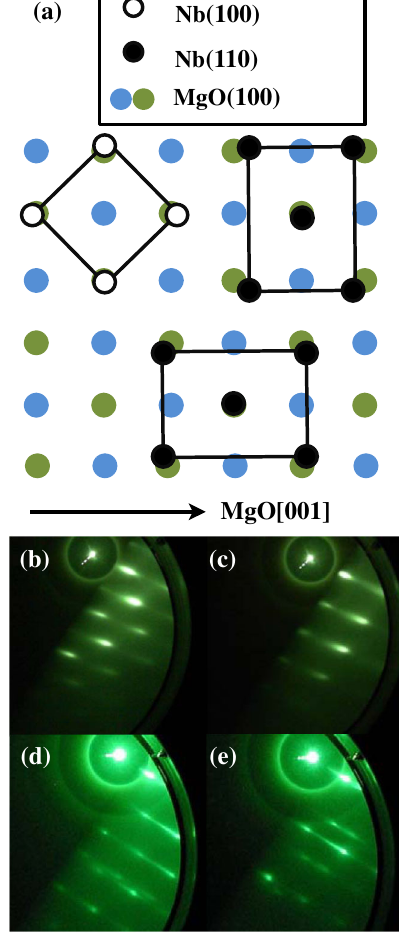
FIG. 5. (a) Atomic representation of epitaxial registry of Nb films with respect to the MgO(001) substrate. (b) RHEED image of 100 nm single crystal Nb ð 100 Þ = MgO ð 001 Þ taken along the MgO[011] azimuth and (c) along the MgO[001] azimuth. (d) RHEED image of the 100 nm Nb Film taken along the MgO[011] azimuth and (e) along the MgO[001]